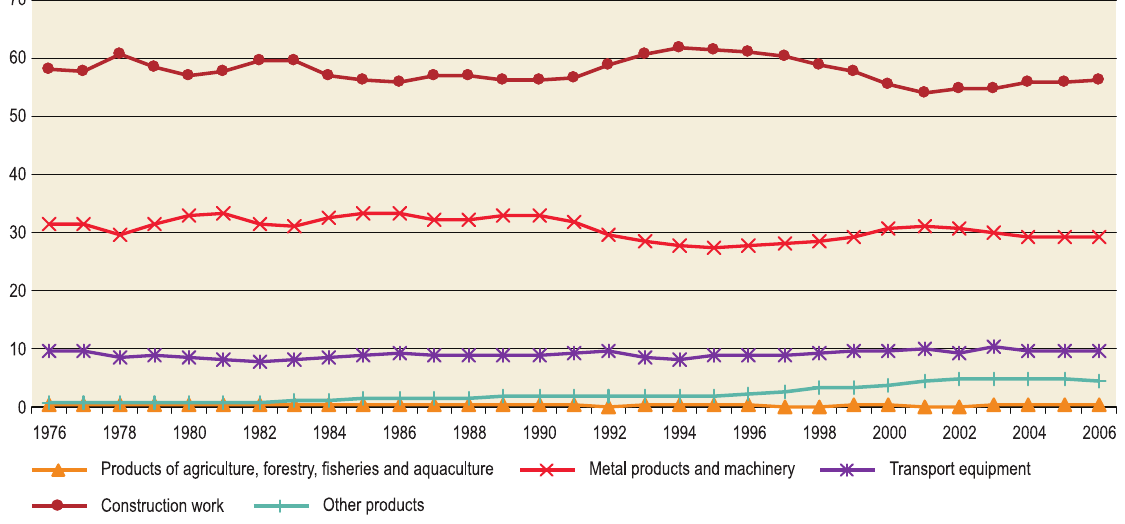
Fig. 6. Fixed investments by 5 asset types in Austria,